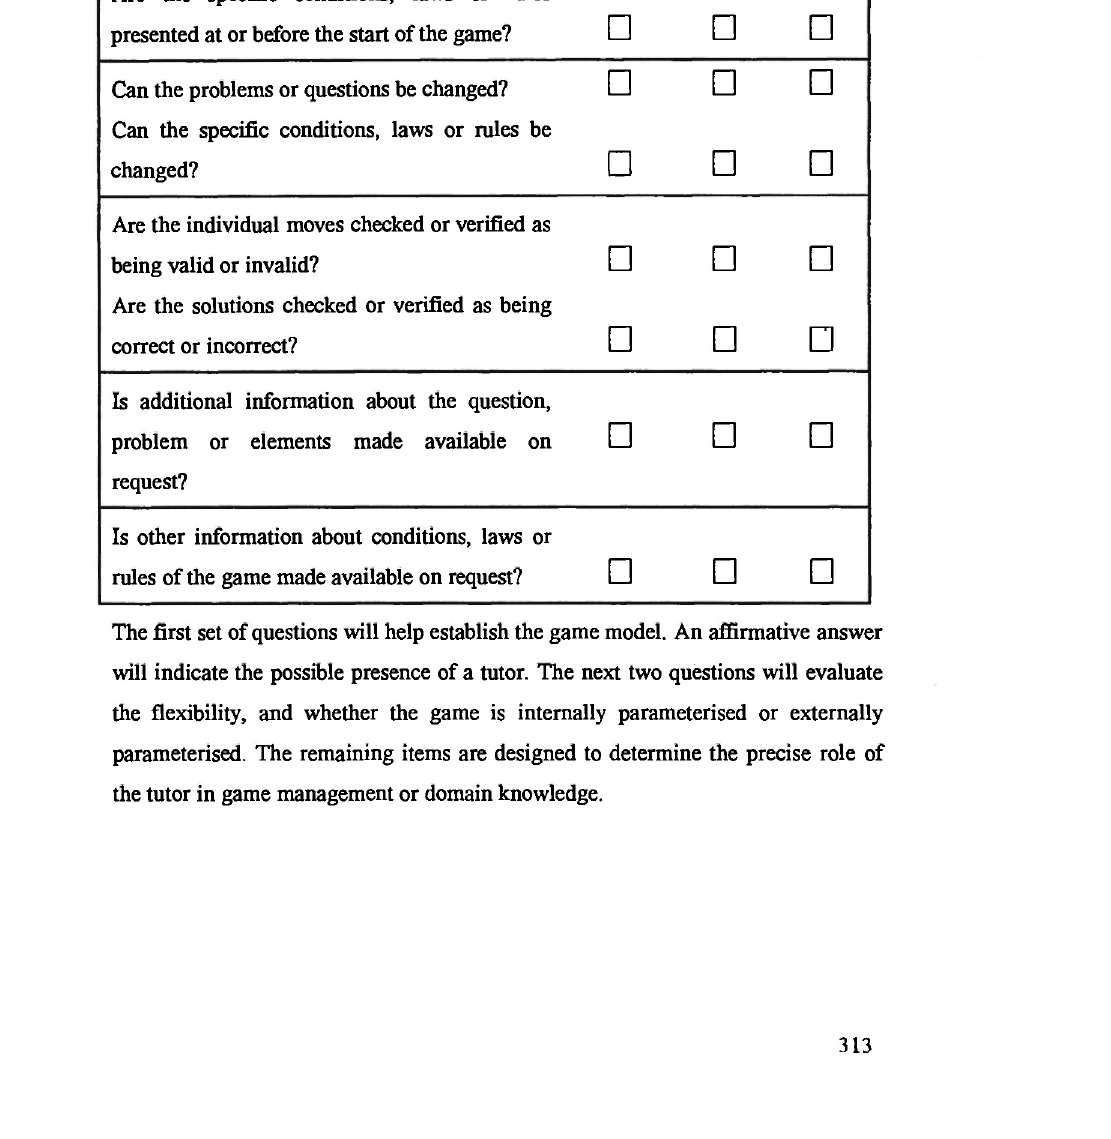
The Evaluation Grid by the by by computer other other game partici- instruc- ants